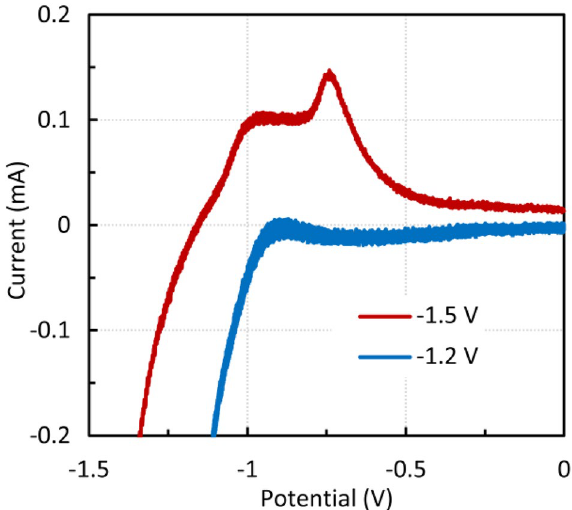
Figure 13. Effect of the starting potential on the anodic peak height, zinc ferrite, 1 M NaOH.